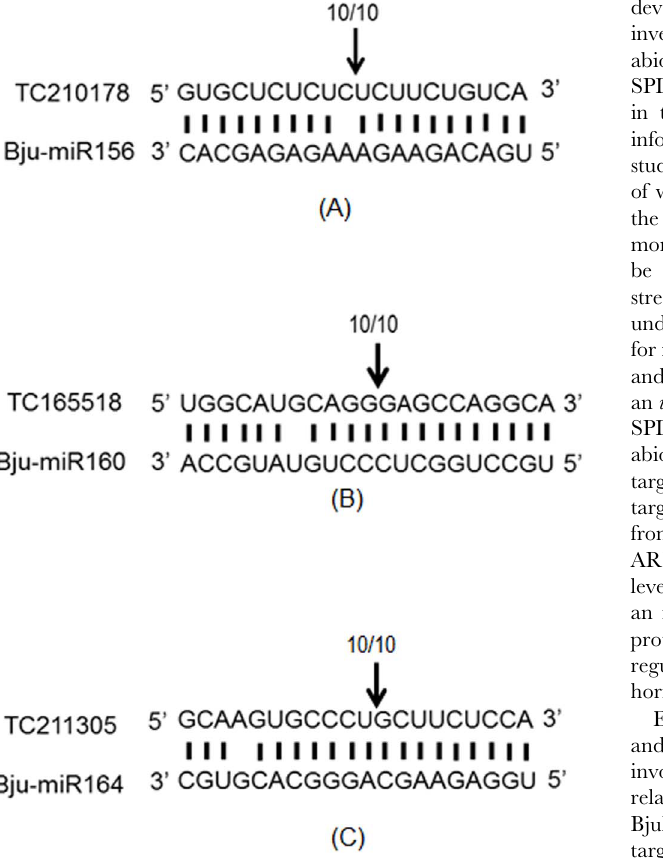
Figure 4. Cleavage site mapping of selected miRNAs using modified RLM-RACE. Targets of the B. juncea miR156 (Bju-miR156), miR160 (Bju-miR160) and miR164 (Bju-miR164) were predicted by psRNA target finder. Primers were designed on the basis of the predicted sequences (TC2101178, TC165518 and TC211305). Cleavage products of three miRNA targets were amplified from RACE library, cloned in pGEMT vector and sequenced. The binding region between the miRNAs and the targets is shown. The arrows indicate cleavage site of transcript and the number of positive clones out of the total clones sequenced is indicated in parentheses above the